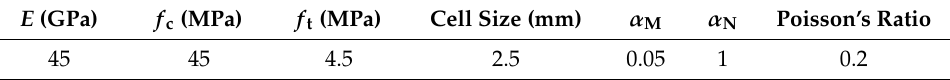
Figure 2. Flowchart of the calibration process. Table 2. Values of input parameters in the numerical